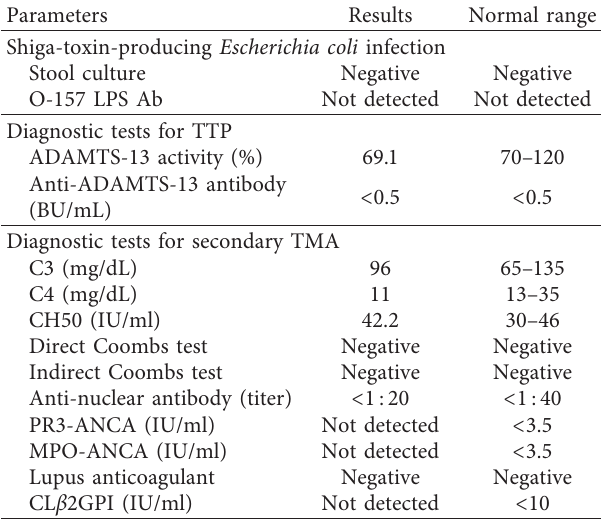
Table 2: Analysis of the responsible gene for